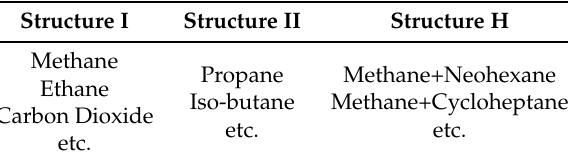
Table 1. Gas hydrates structures and guest molecules. Structure I Structure II Structure H Methane Propane Iso-butane Carbon Dioxide etc. etc. etc.